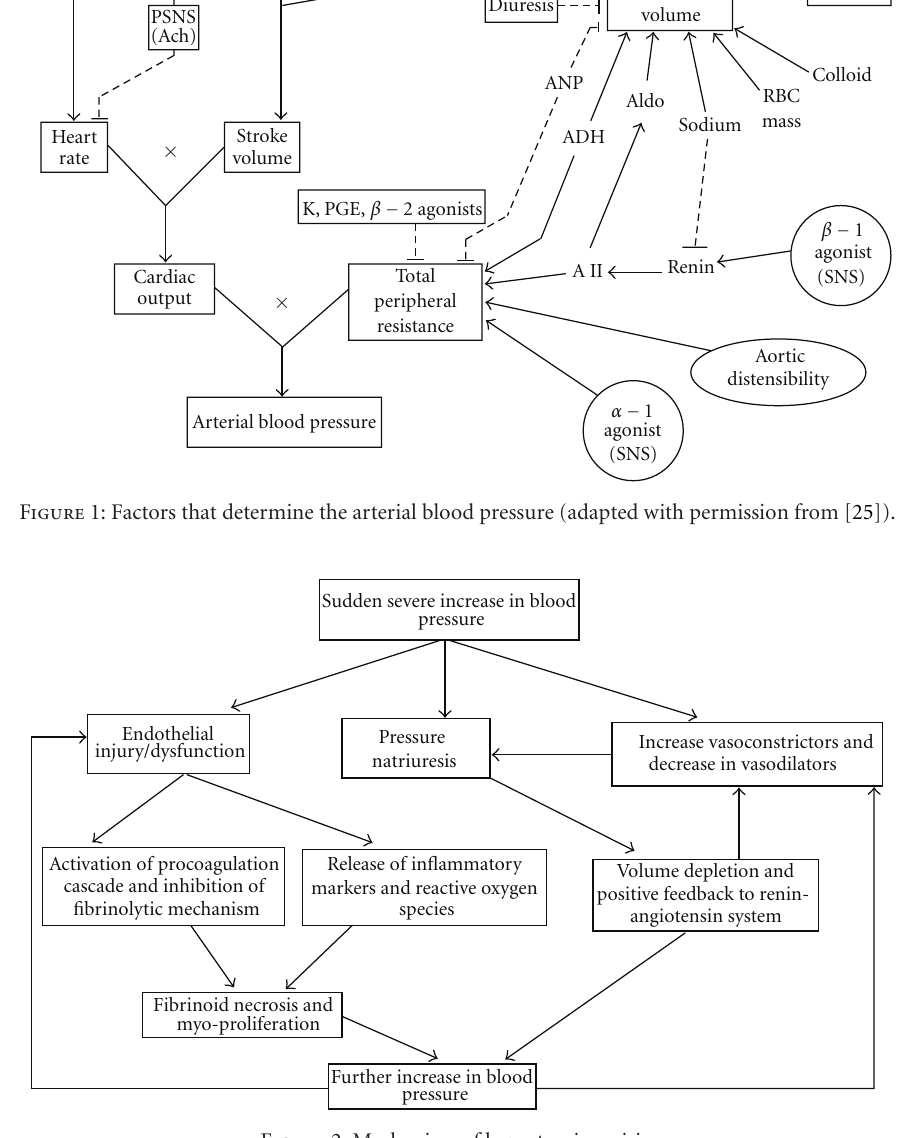
Figure 2: Mechanism of hypertensive crisis. Table 3: Age-specific reference values of the LVMI in boys and girls Adapted from